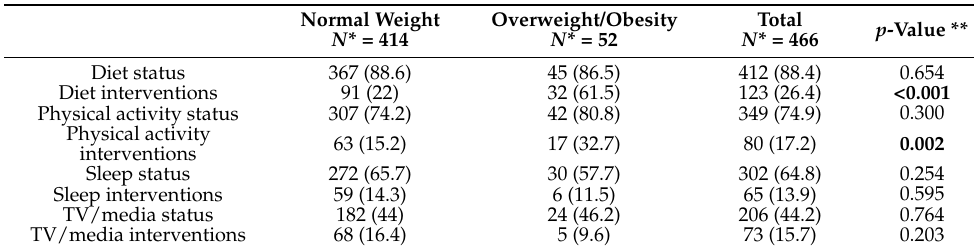
Table 3. Documentation of status and interventions regarding lifestyle habits in relation to the child’s